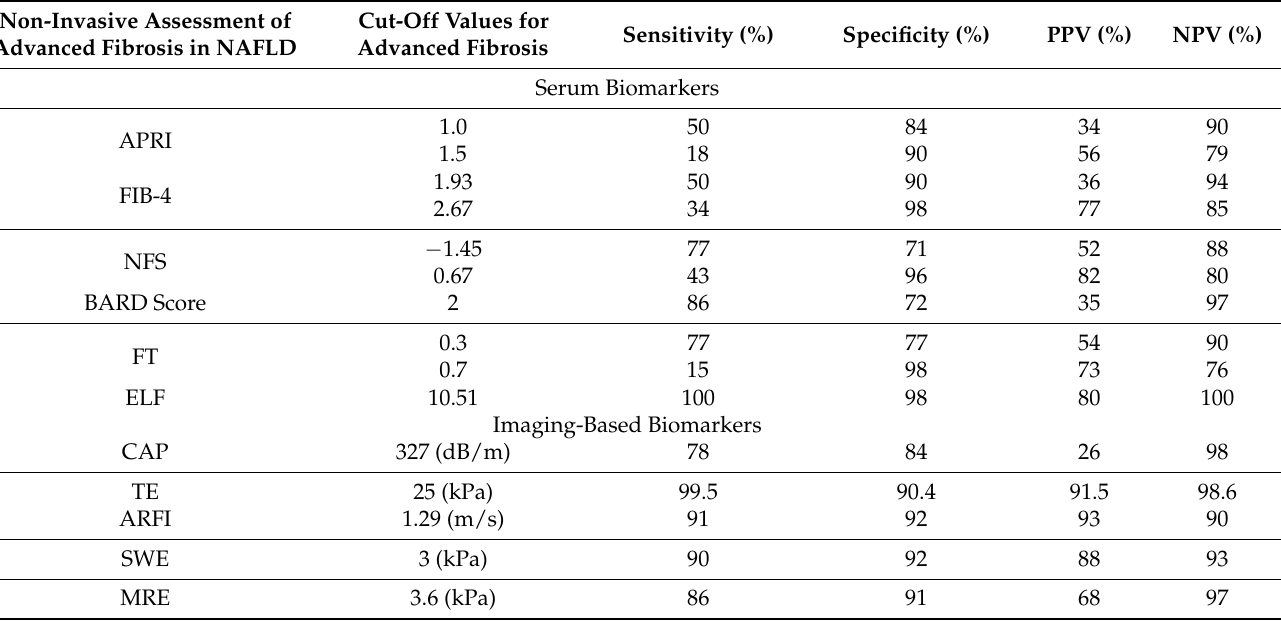
Table 2. Non-invasive assessment of advanced fibrosis in NAFLD. Cut-off values, sensitivity, speci- ficity, PPV,